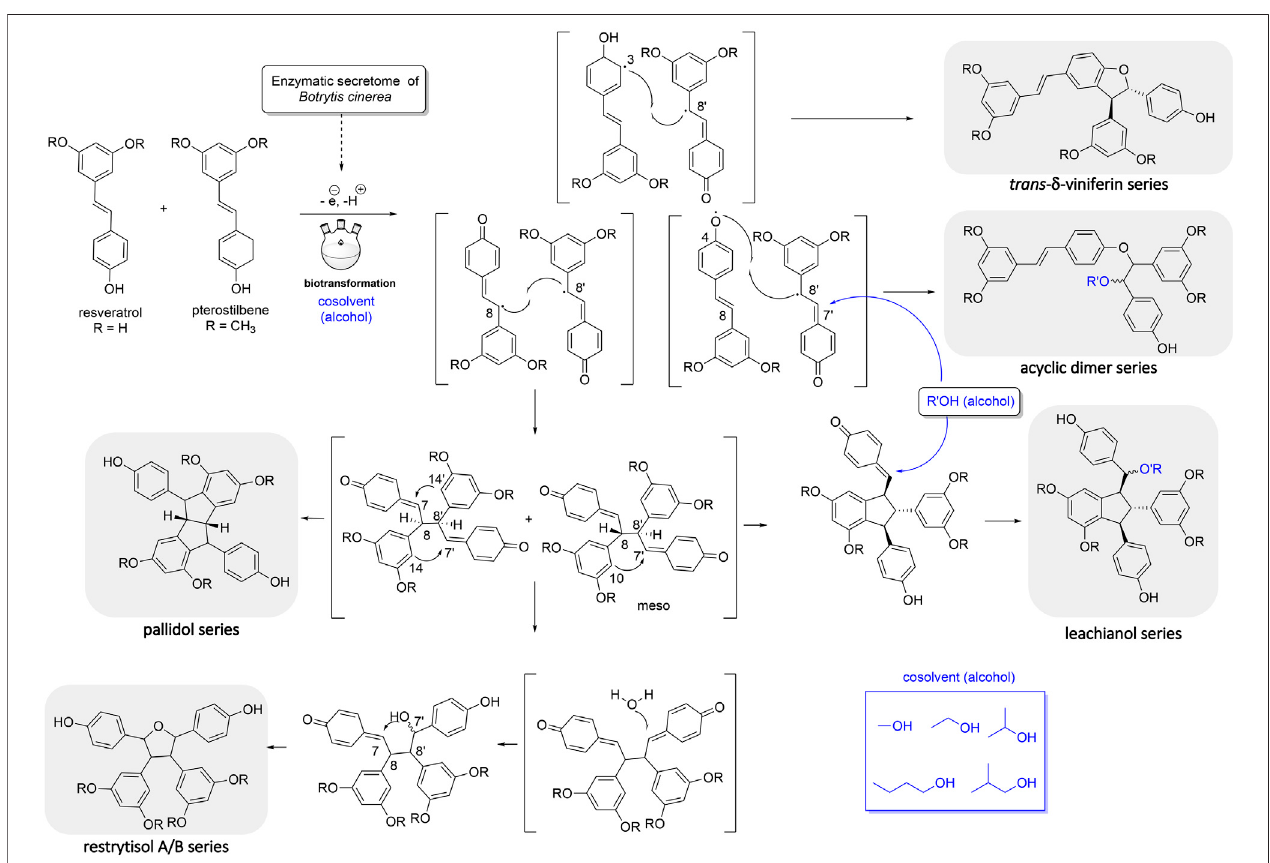
FIGURE 4 | Mechanism of reaction explaining the generation of the 5 main scaffolds (trans- δ -viniferin, acyclic dimer, leachianol, pallidol, restrytisol A/B) of stilbene dimers obtained by the biotransformation reaction of resveratrol and pterostilbene using the enzymatic secretome of Botrytis cinerea in the presence of alcohol as